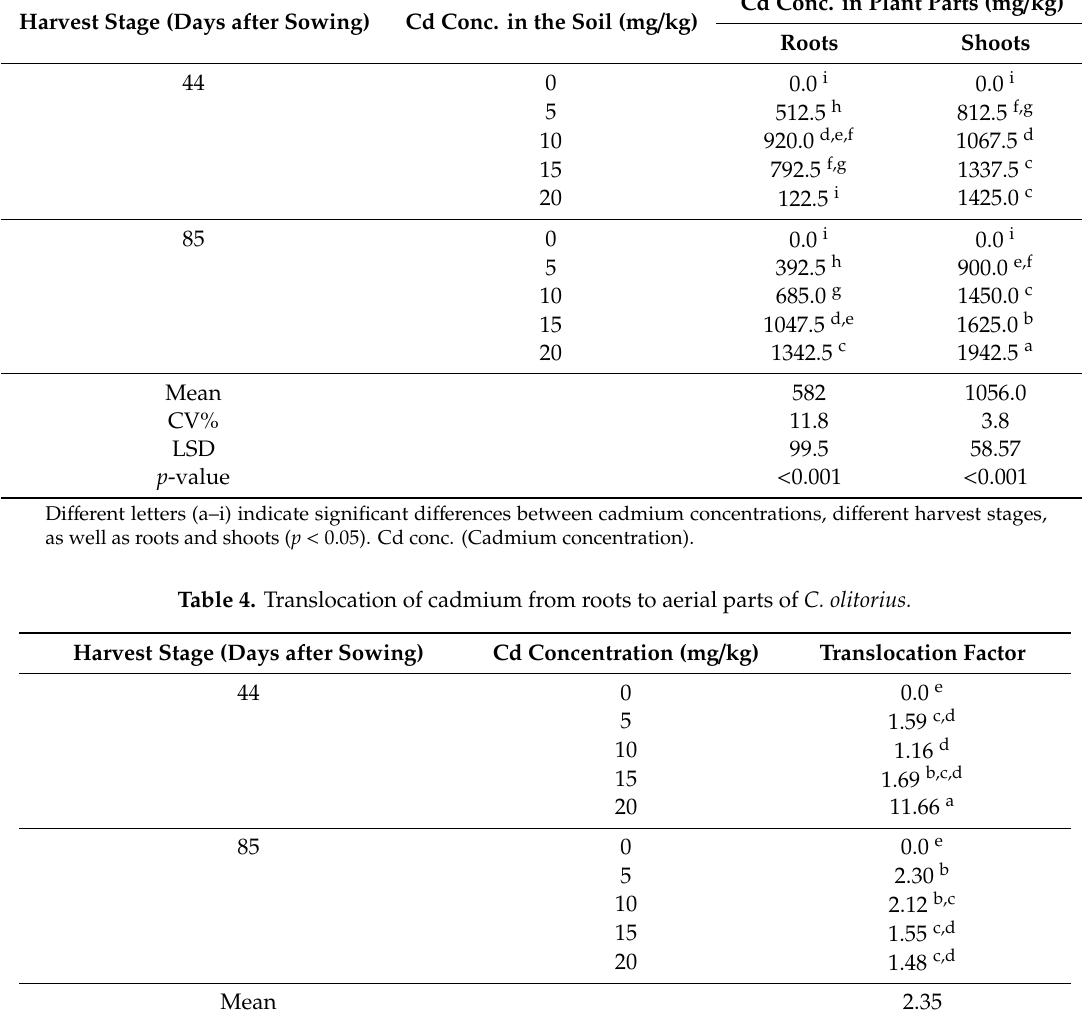
Table 3. Accumulation of cadmium in roots and shoots of C. olitorius.